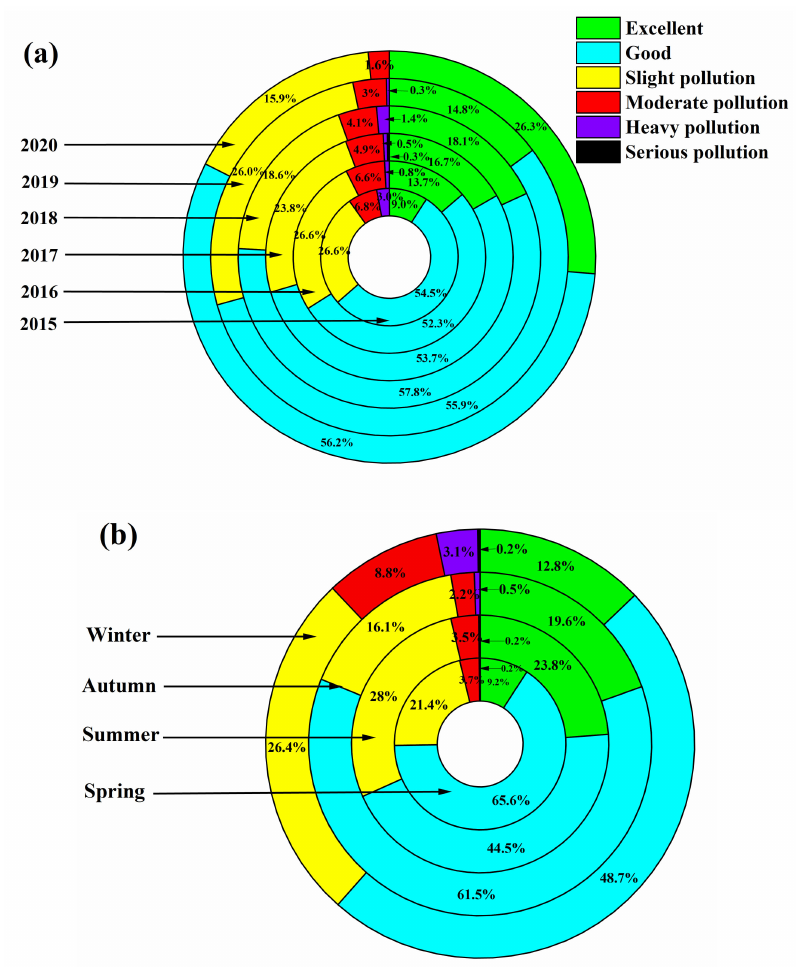
Figure 1. ( a ) Annual proportions of days with different air quality levels in 2015–2020; ( b ) Seasonal proportions of days with different air quality levels in